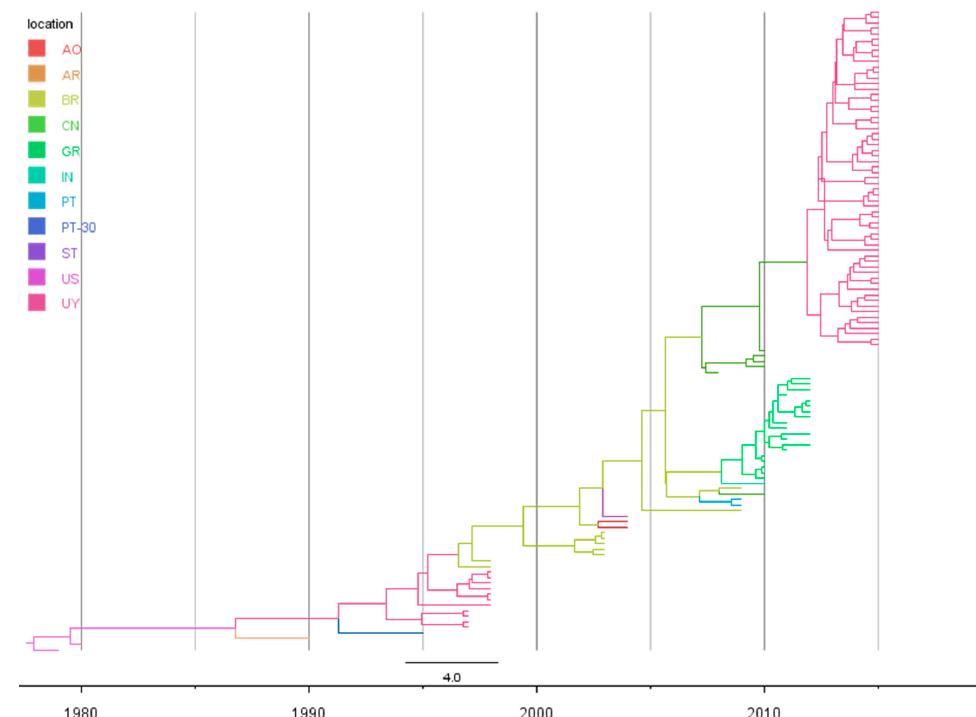
Figure 1. Time-scaled Bayesian MCC phylogeny of CTV-NC genotype. Sequences from different countries encompassing the p25 gene were used to phylogeny reconstruction. Branches were colored according to the most probable location of their parental nodes. AO: Angola; AR: Argentina; BR: Brazil; CN: China; GR: Greece; IN: India; PT: Portugal; PT-30: Madeira Island; ST: Sao Tomé and Príncipe; US: United States; UY: Uruguay.